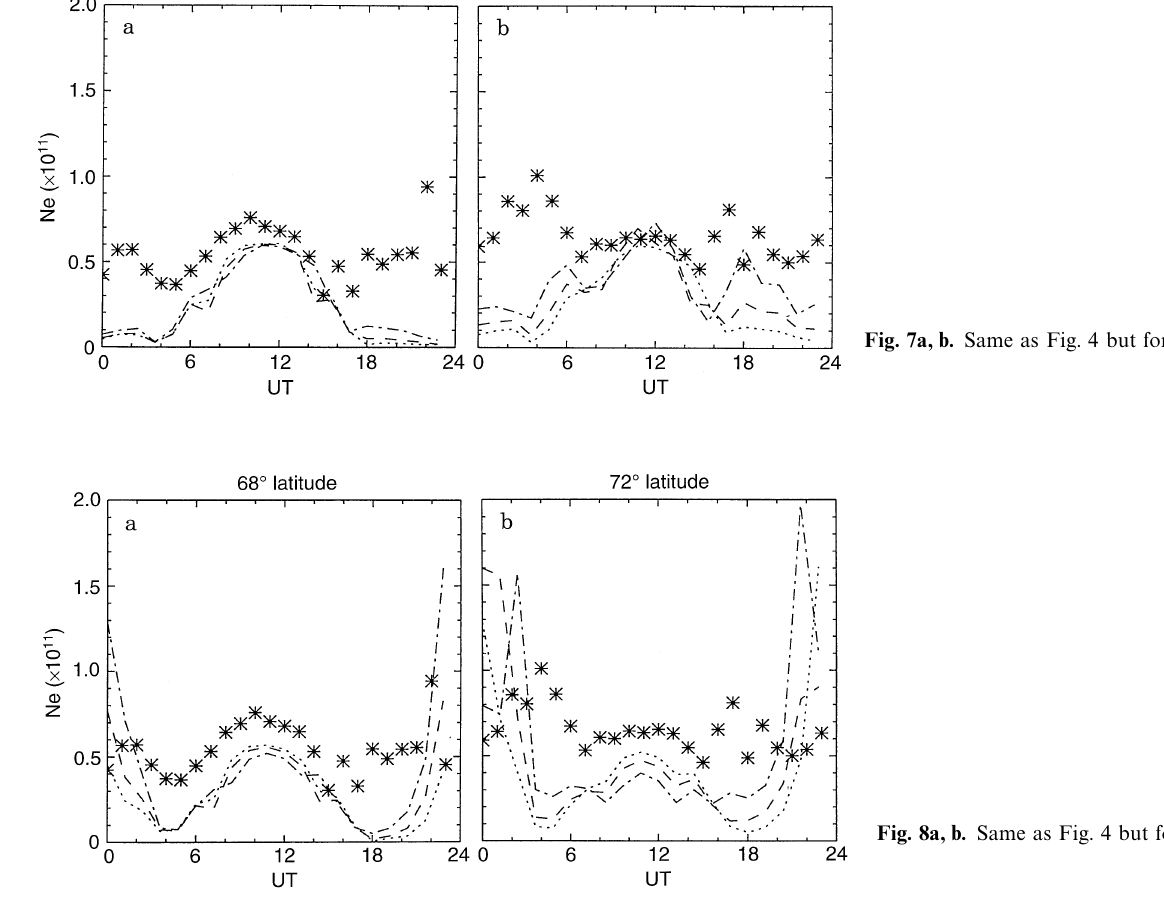
Fig. 7a, b. Same as Fig. 4 but for